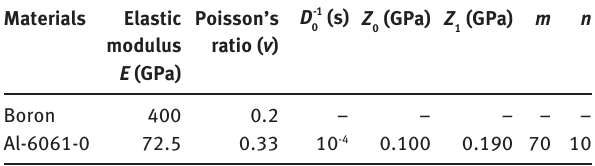
Table 1 Material parameters of boron/Al-6061-0 [23].